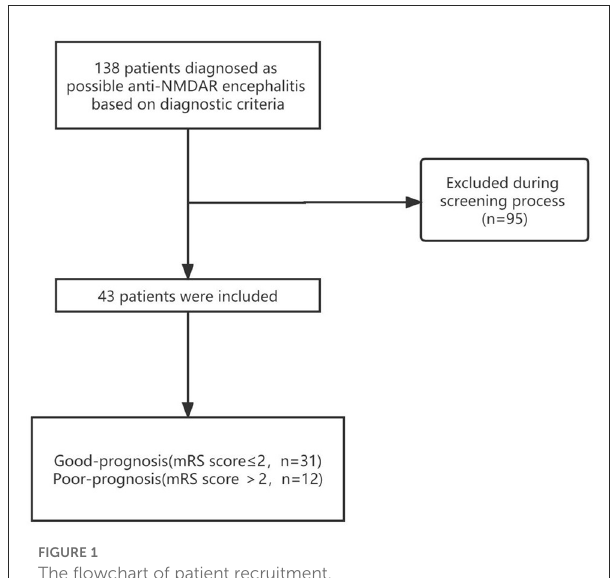
FIGURE1 The flowchart of patient